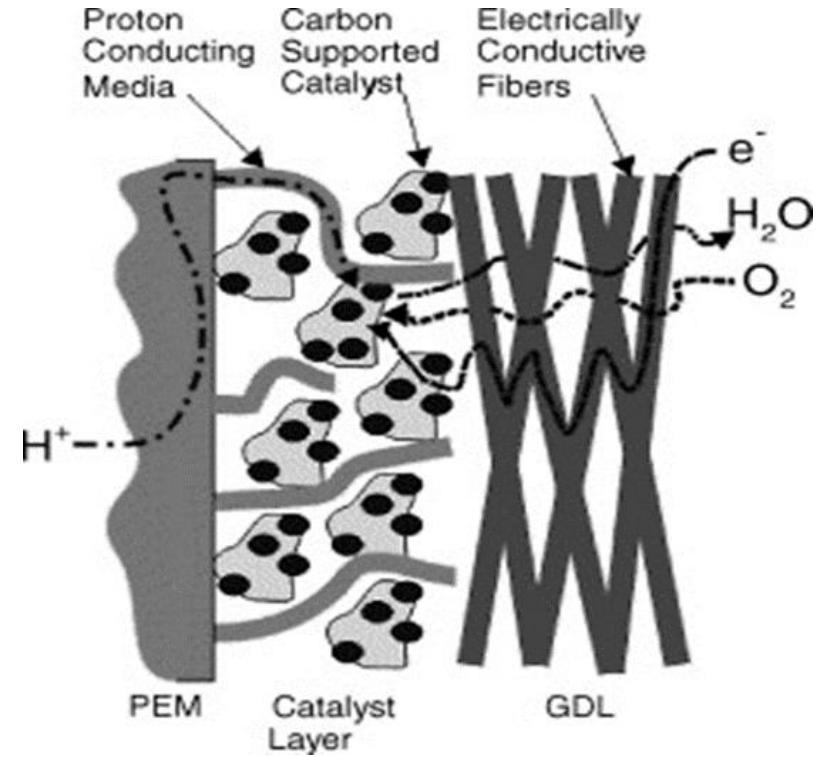
Figure 5. Cross section of PEMFC showing flow-through catalyst layer [59] (license no. 5172460708856).